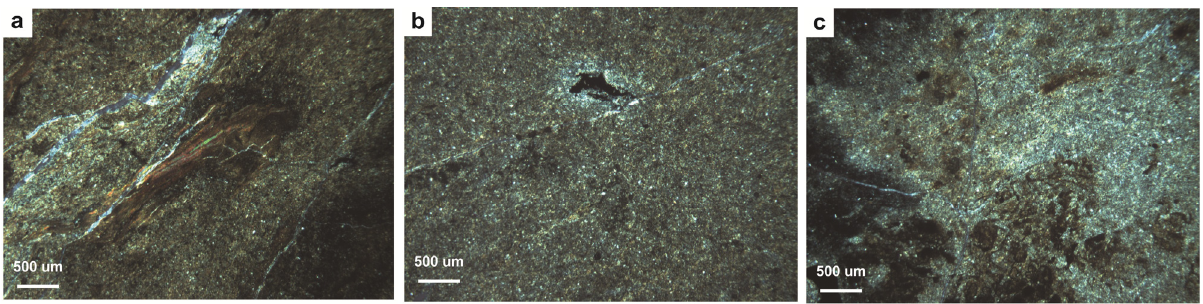
Figure 6. Plasmic microfabrics from the Type A paleosols: ( a ) A patch of high birefringence clay within a matrix of insepic plasmic microfabric; ( b ) An insepic microfabric with local gleization around a rhizohalo; ( c ) A mosepic plasmic